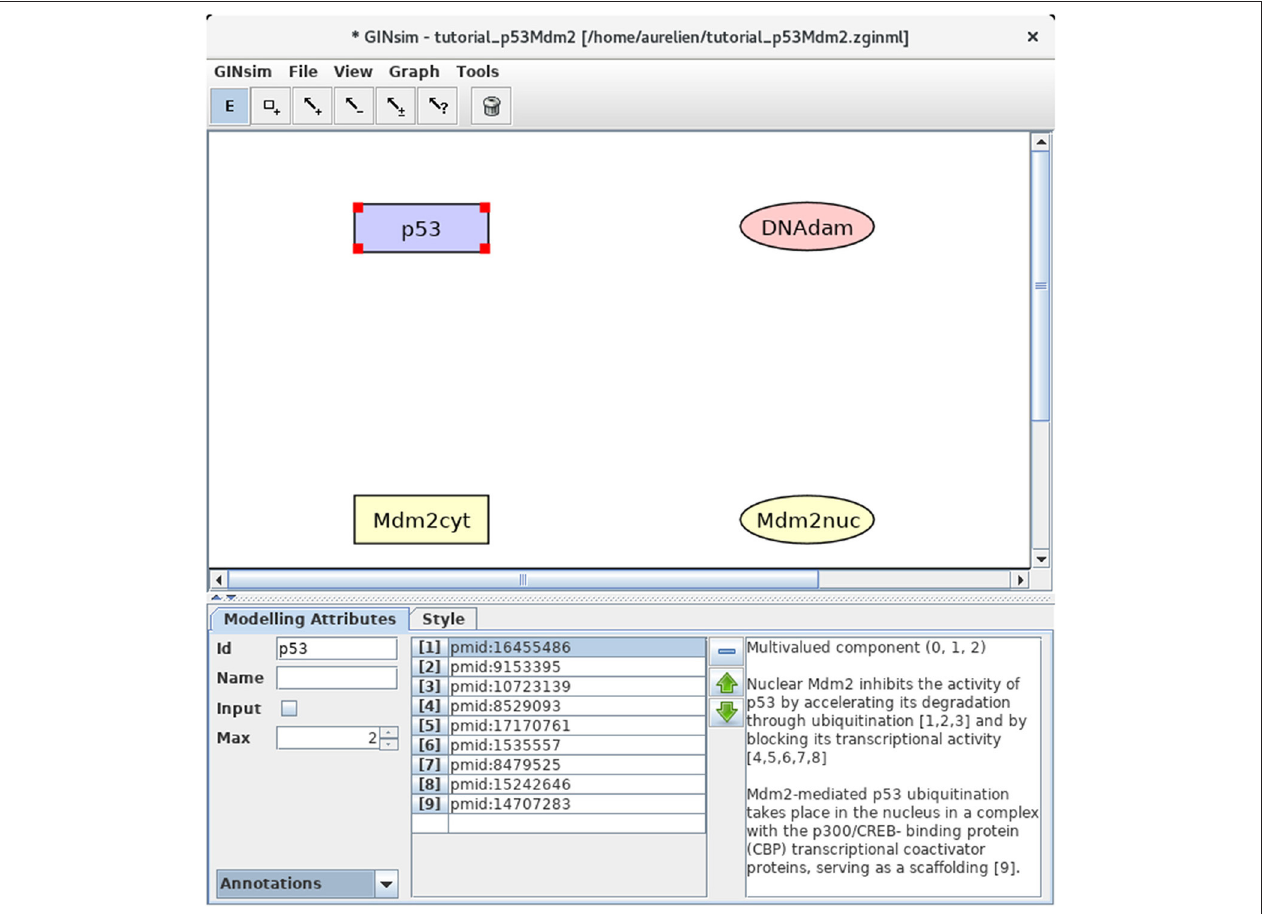
FIGURE 2 | GINsim main window displaying the nodes of the p53-Mdm2 logical regulatory graph. The upper part of the window displays five scrolling menus. These menus provide access to classical file management options, as well as exports into various formats. The central area displays the regulatory graph (here the nodes of the p53-Mdm2 model), while the other area contains two tabs: the Modeling Attributes tab (selected here) and the Style tab, corresponding to the selected node, here p53. The graphical appearance of the nodes have been modified using the Style tab. The Edit button on the top is selected and emphasized in blue, enabling the edition of the attributes of the selected node, including its id and name, its maximal level ( Max , here set to 2), and also the insertion of annotations in the form of free text (bottom right) or of links to relevant database entries (bottom middle).